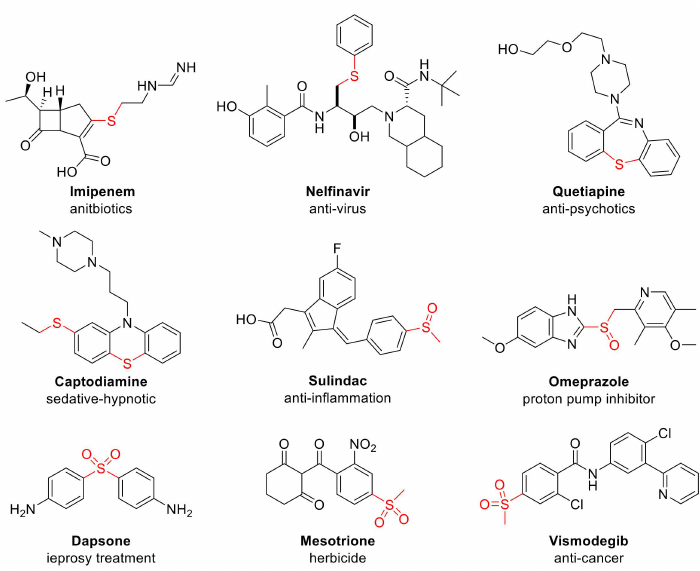
Figure 1. Representative drugs featured by sulfide, sulfoxide, or